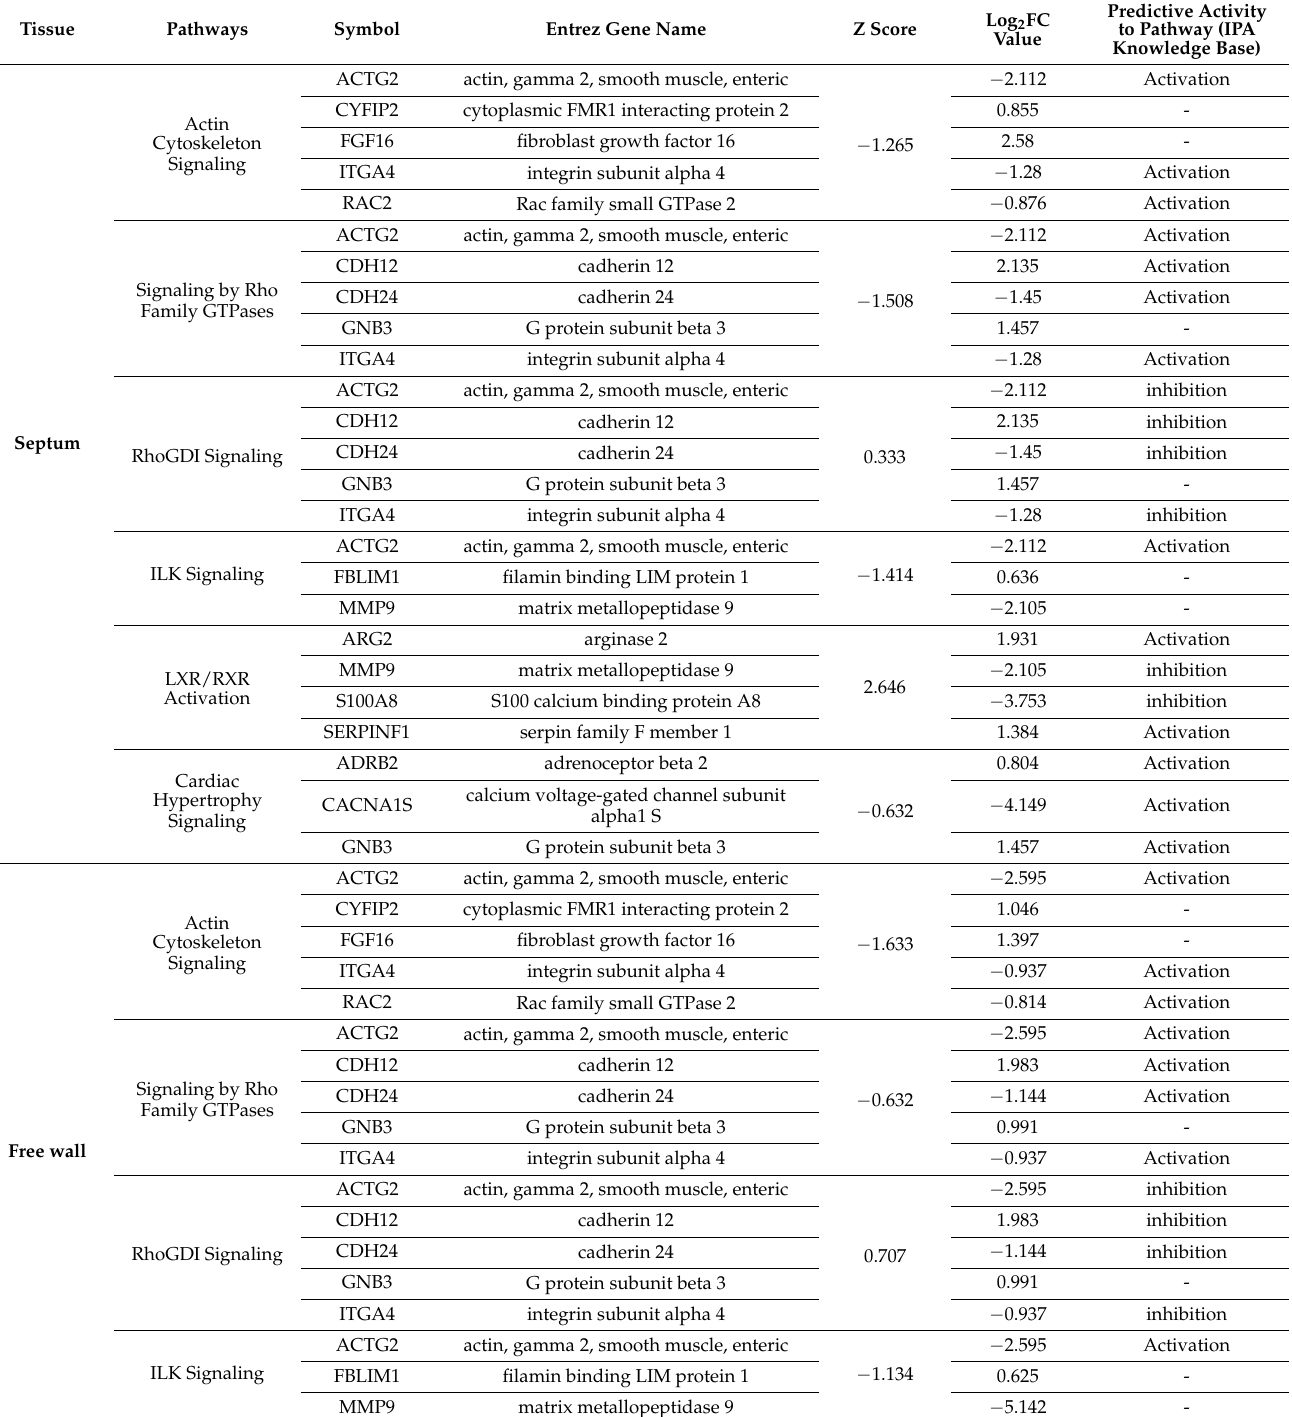
Table 1. Log 2 fold change values and predictive activity of the differentially expressed genes significantly involved in the actin cytoskeleton signaling